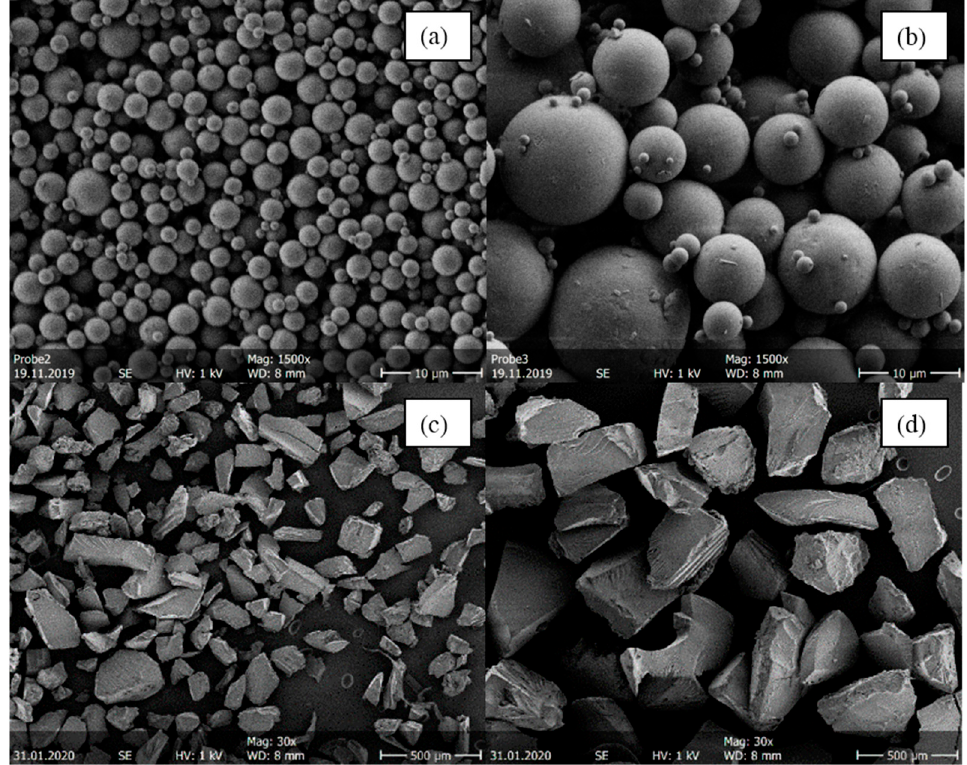
Figure 3. SEM images of four ITR/Soluplus ® ASDs with 20 wt.% ITR. ( a ) Small spray-dried particles (d 3,50 = 2.43 µm), ( b ) large spray-dried particles ( d 3,50 = 15.28 µm), ( c ) small melt-extruded particles (d (cid:3365) = 162.5 µm), and ( d ) large hot meld extruded particles ( d (cid:3364) = 277.5 µm). Spray-dried samples were imaged with 1500× magnification, melt-extruded samples with 30× magnification.